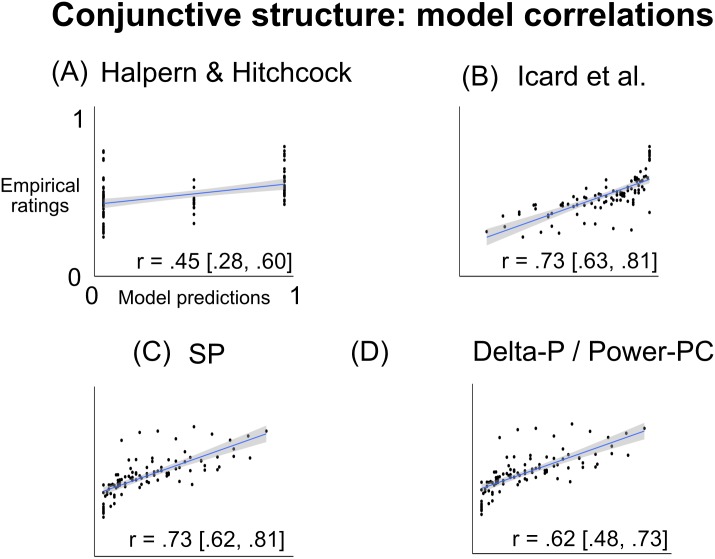
Correlation between model predictions and empirical ratings, across the various parameterizations of Prob(focal) and Prob(alternate).Each point represents one joint setting of the two probabilities (e.g. one point might capture the case where Prob(focal) = .7 and Prob(alternate) = .4); its location on the x-axis represents the model’s predicted rating for that parameterization, and its location on the y-axis represents people’s average causal ratings for that parameterization. For each model, we show a least-squares trend line (with 95% confidence intervals around it), and compute a Pearson correlation coefficient between the predicted and empirical ratings (with 95% confidence intervals in brackets). Overall, the Icard and SP models were the most accurate predictors of people’s average causal ratings across conditions.